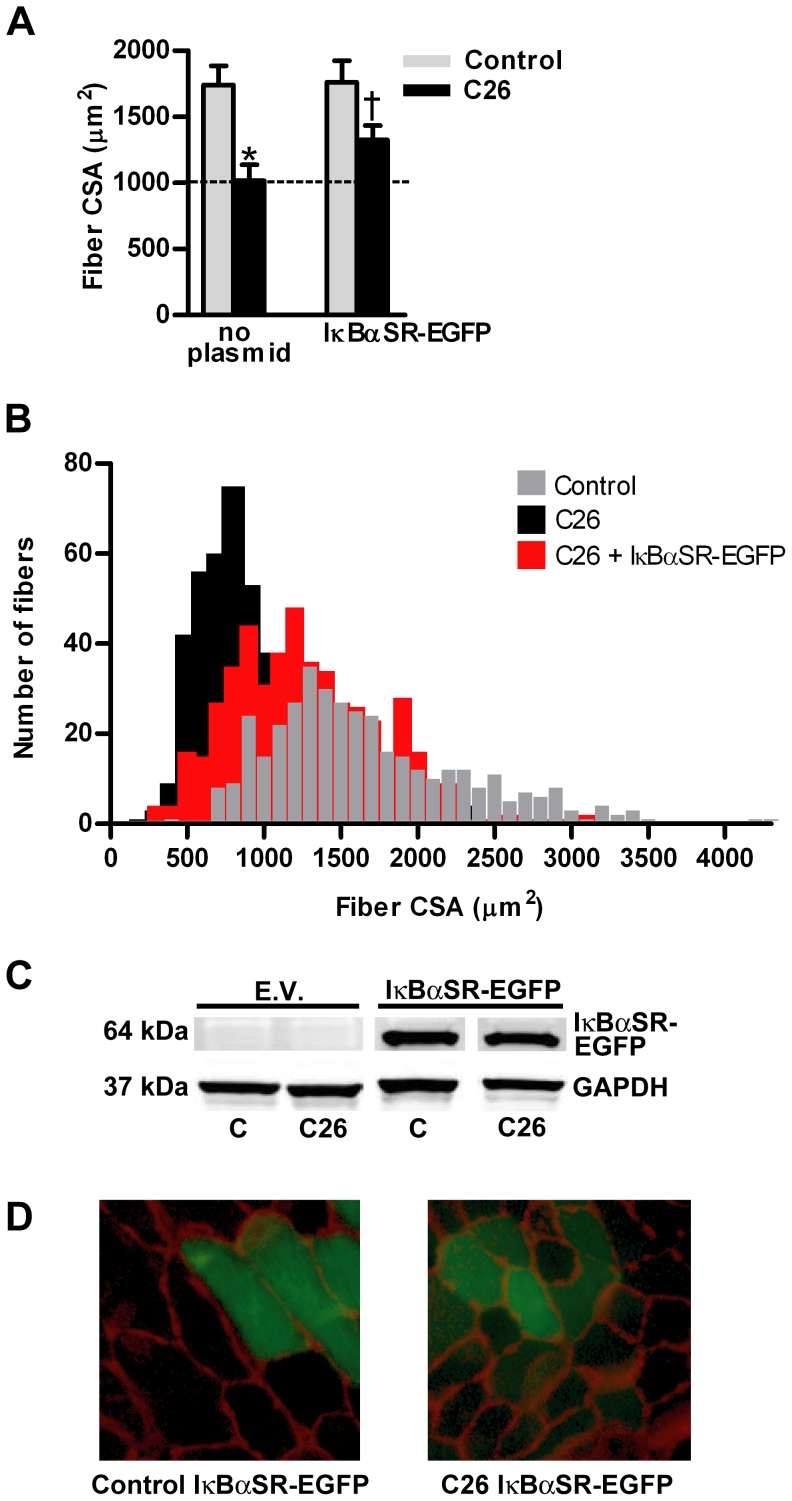
Effects of IκBαSR-EGFP on muscle fiber cross sectional area (CSA).(A) Mean tibialis anterior (TA) fiber cross-sectional area in control and C26 tumor-bearing mice in the presence or absence of IκBαSR-EGFP. Each bar represents mean fiber area from 8 muscles (± SE). (B) Fiber area frequency distribution of all fibers from muscles of control, C26, and C26 + IκBαSR-EGFP groups. (C) Western blots of lysates from TA muscles injected with the empty vector (EV) or IκBαSR-EGFP plasmid confirms overexpression of the fusion protein. IκBαSR-EGFP is 64 kDa. All samples are from the same immunoblot. (D) Representative cross sections of TA muscles from control and C26 tumor-bearing mice injected with the IκBαSR-EGFP plasmid. C  =  control. * significantly different from control (P<0.05). † significantly different from C26 fibers not transfected with IκBαSR-EGFP (P<0.05).